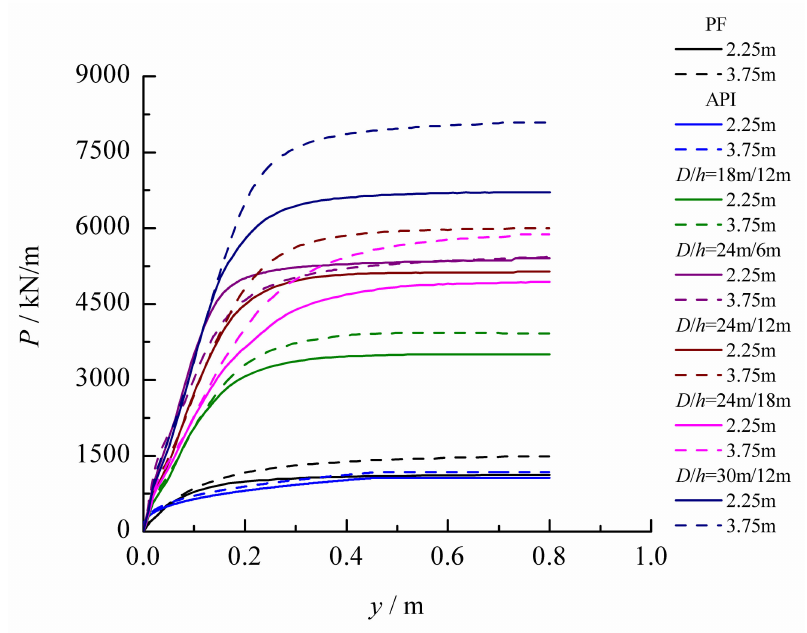
Figure 14. p - y curve of the pile–bucket foundation. Table 7. (a) The increment of P ult at a depth of 2.25 m; (b) The increment of P ult at a depth of 3.75